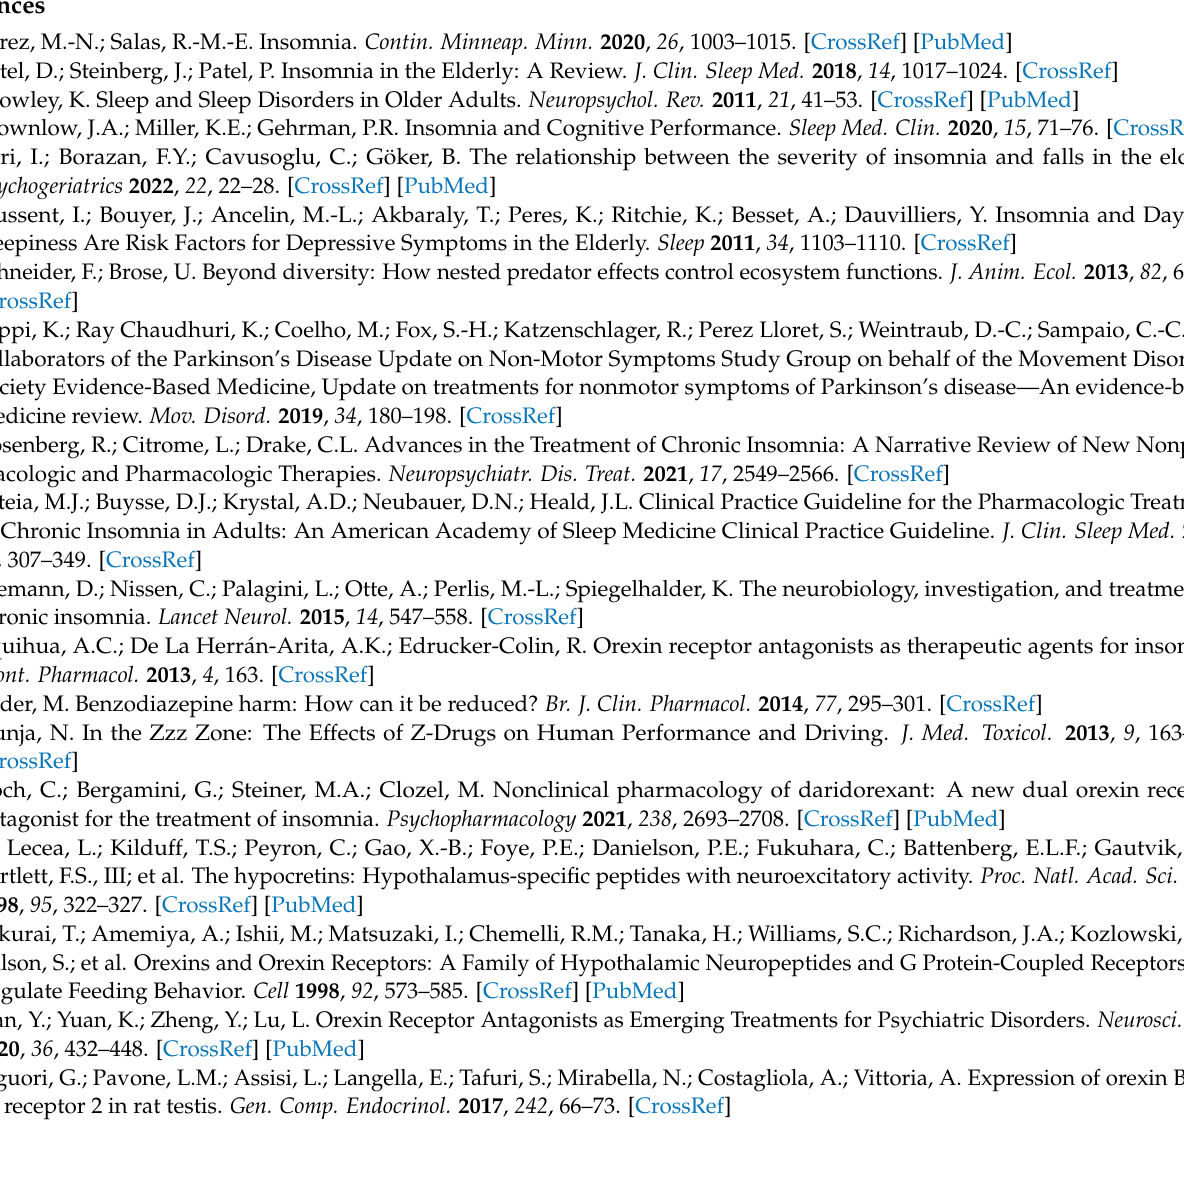
multiflorum thumb; Figure S56: The chemical structures of Polygonum multiflorum thumb; Table S26: Chemical composition of Nelumbo nucifera gaertn; Figure S57: The chemical structures of Nelumbo nucifera gaertn. References [40–77] are cited in the supplementary